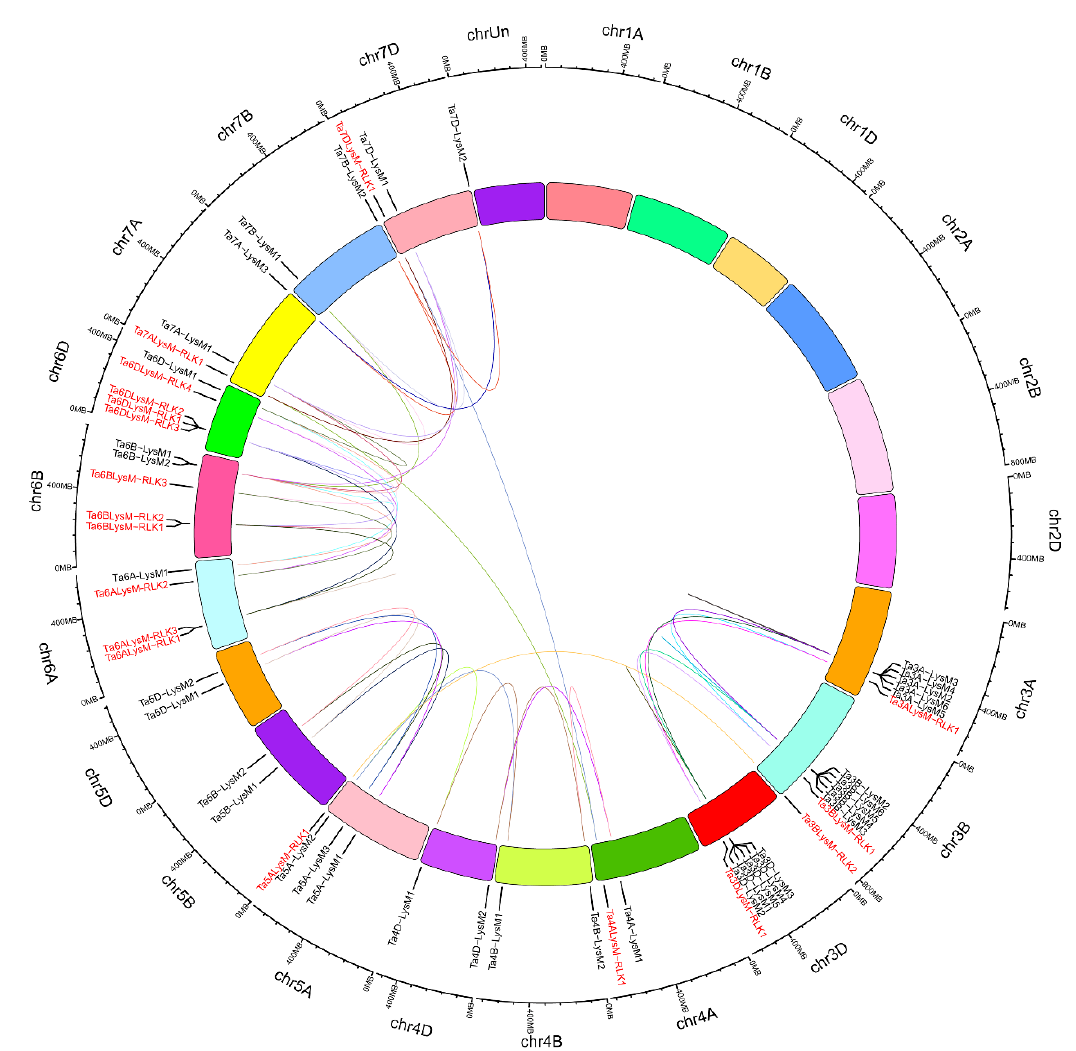
Figure 5. The interchromosomal relationships of LYP and LYK genes in wheat. The colored lines inside indicate duplicated LYP and LYK gene pairs. Distribution of LYP genes (black) and LYK genes (red) in the three subgenomes. The chromosome number is shown on the outside of the chromosomes. The numbers at the outside represent the length of the chromosomes and also provide the locations of these genes on their chromosomes.